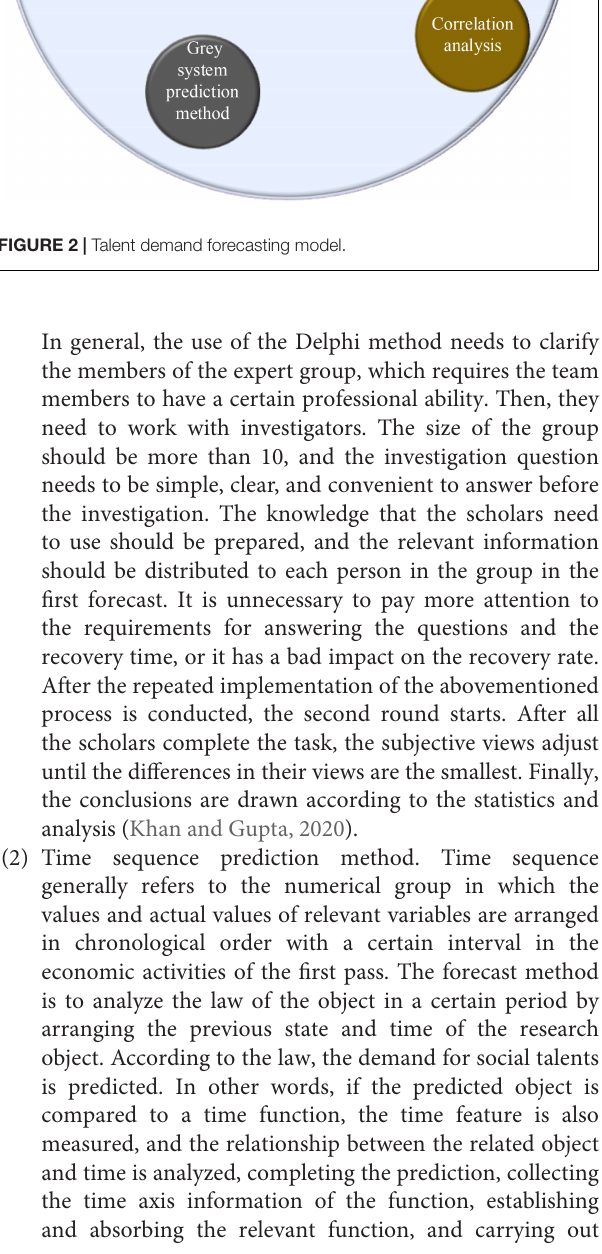
FIGURE 1 | Design of the ideal curriculum.